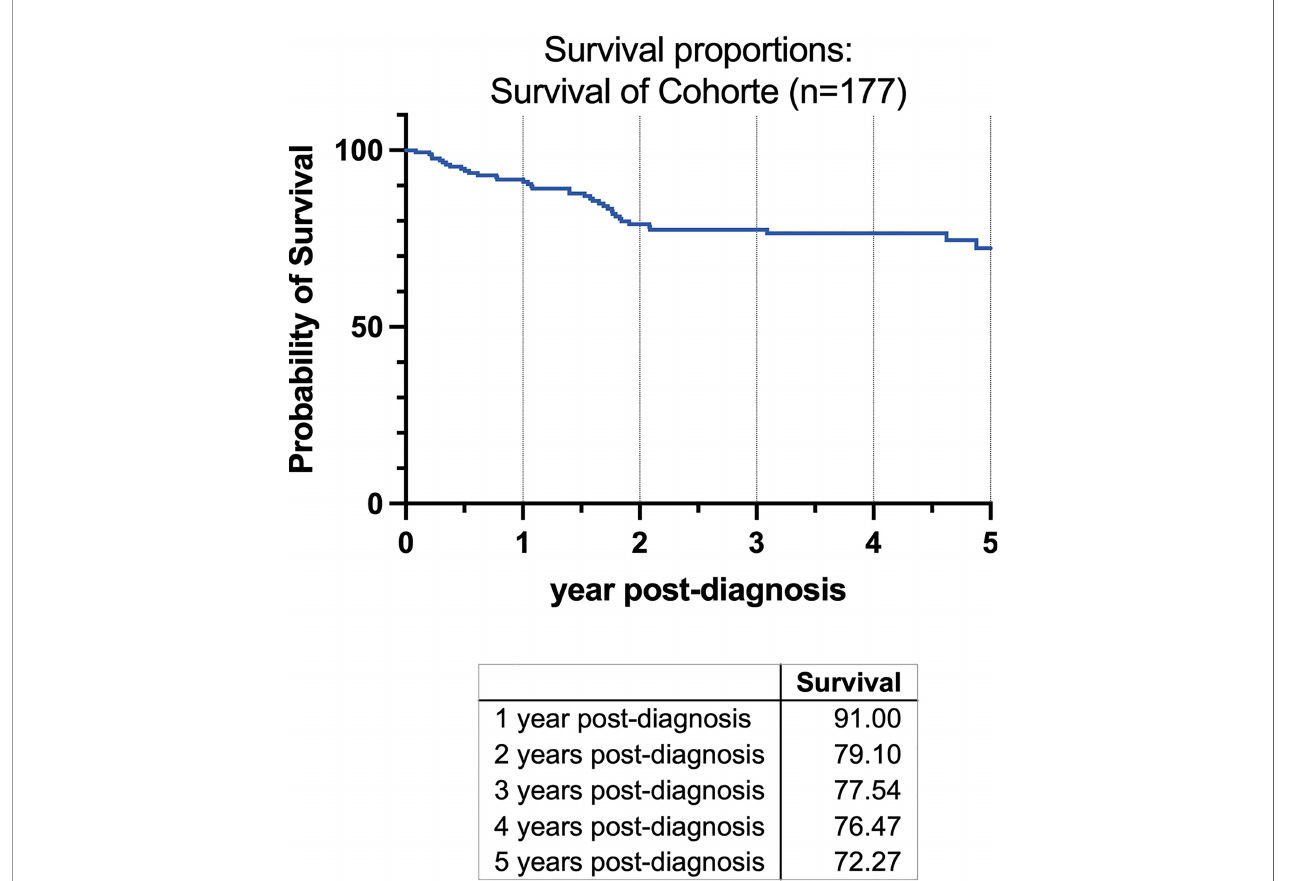
FIGURE 1 | Kaplan-Meier-Graph of all patients for 5 years beginning at the time of the initial diagnosis. Survival in the fi rst year was 91%, 79.1% in the second year after diagnosis, 77.54% in third, 76.47% in fourth and 72.72% after fi ve years.